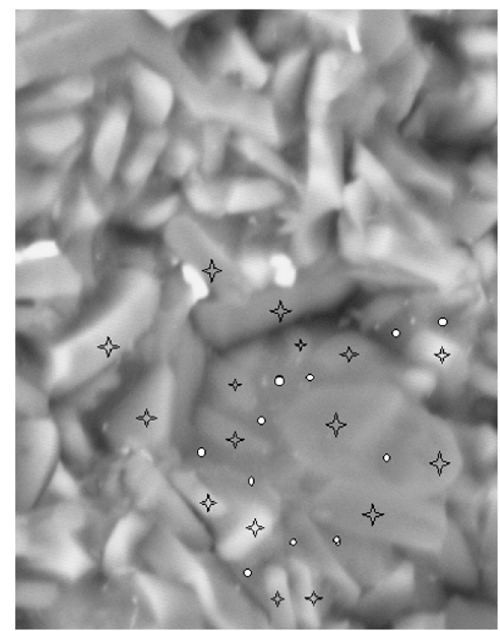
21: alumina and C